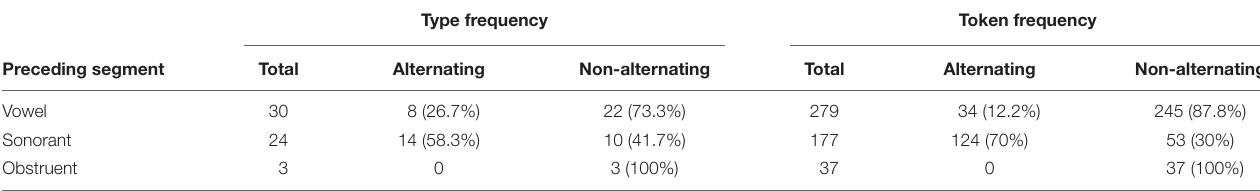
TABLE 2 | Distribution of alternations in singular–plural pairs broken down by the phonological properties of the preceding segment. Type frequency Token